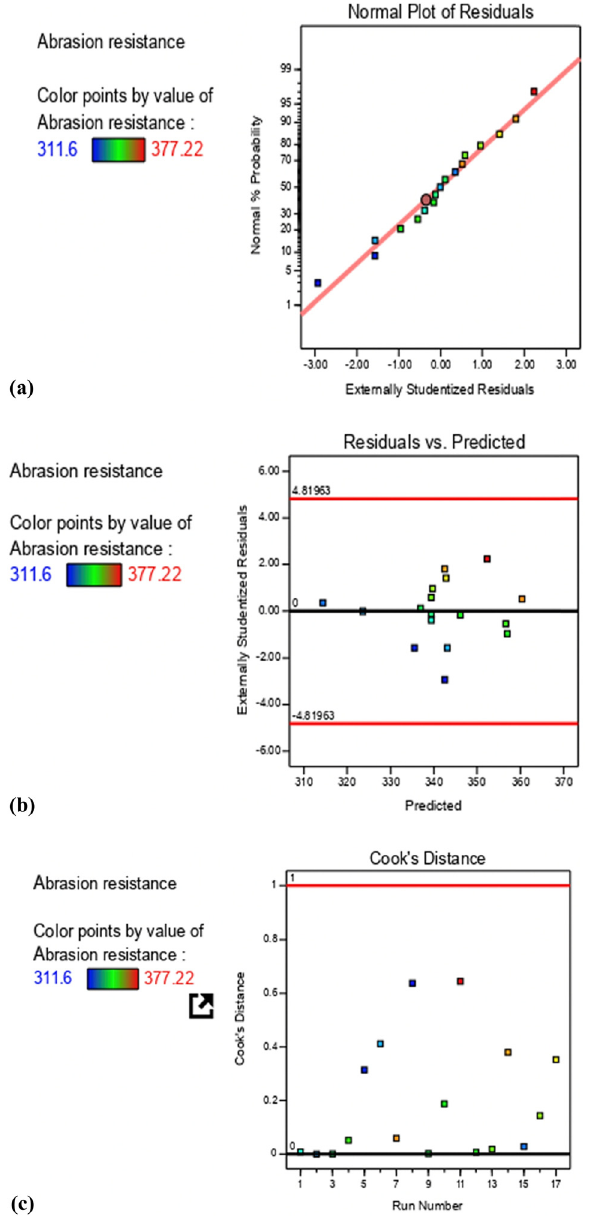
Figure 24: ( a ) Normal percent probability graph for abrasion resis - tance. ( b ) Residual vs predicted graph for abrasion resistance. ( c ) Residual vs run graph for abrasion